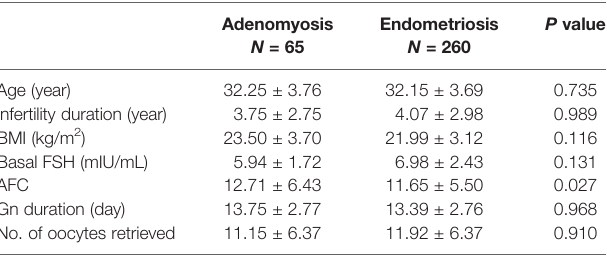
TABLE 2 | Basic parameters and clinical outcome for patients undergoing IVF/ ICSI with and without uterine adenomyosis.